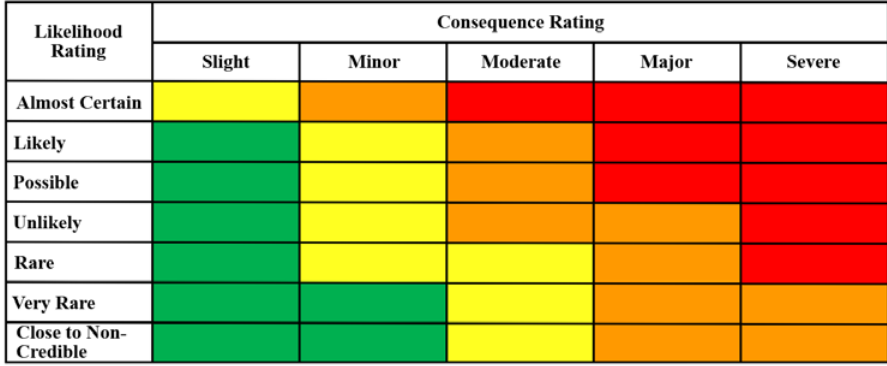
Figure A6. Example colour-coded risk matrix.